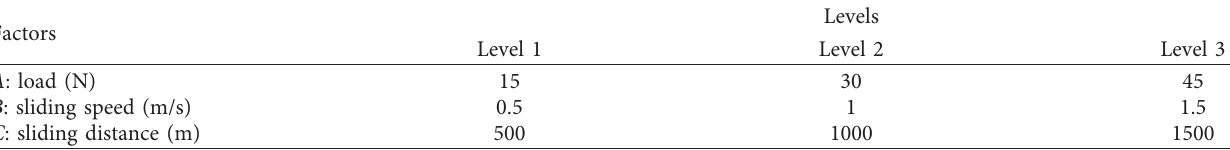
Table 1: Wear test factors and their levels.